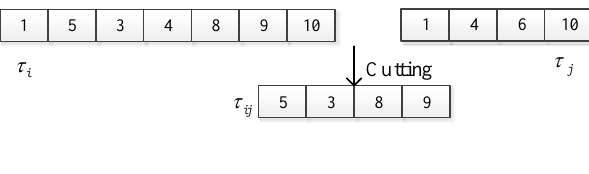
Figure 9. Different genes in two solutions.